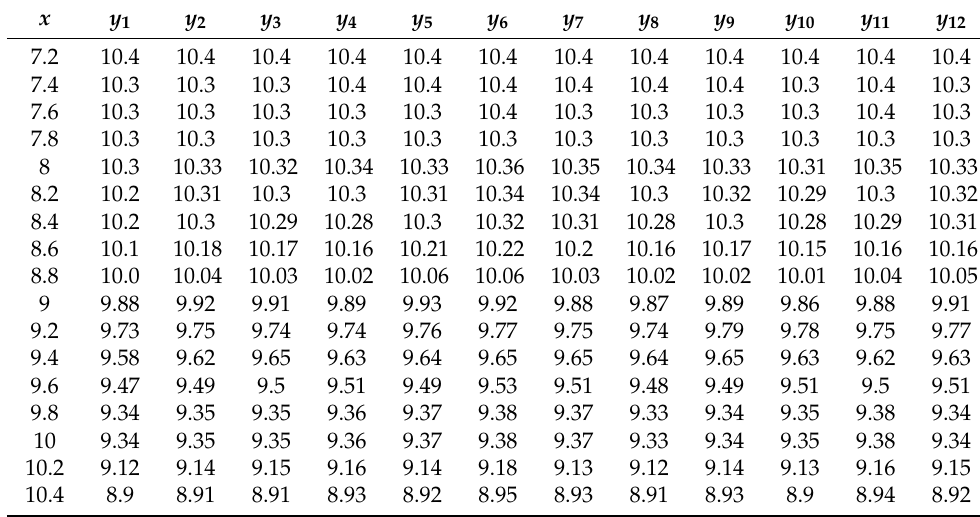
Table A2. The coordinates ( x , y ) of the ultrasound data points for the shape of the vitreous for 12 patients (part